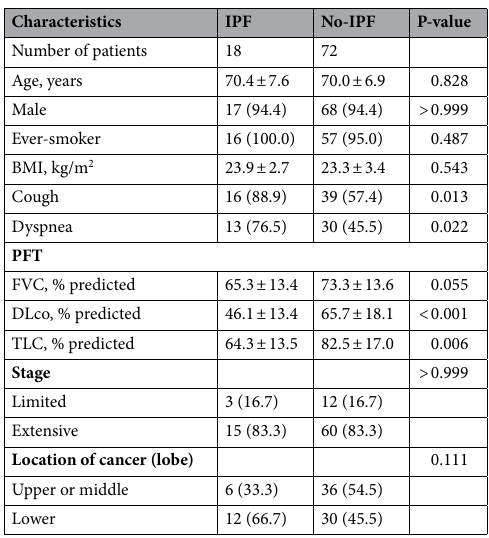
Table 2. Comparison of the baseline characteristics of SCLC between patients in the IPF and no-IPF groups. Data are presented as mean ± SD or number (%), unless otherwise indicated. SCLC small cell lung cancer, IPF idiopathic pulmonary fibrosis, BMI body mass index, PFT pulmonary function test, FVC forced vital capacity, DLco diffusing capacity for carbon monoxide, TLC total lung capacity.